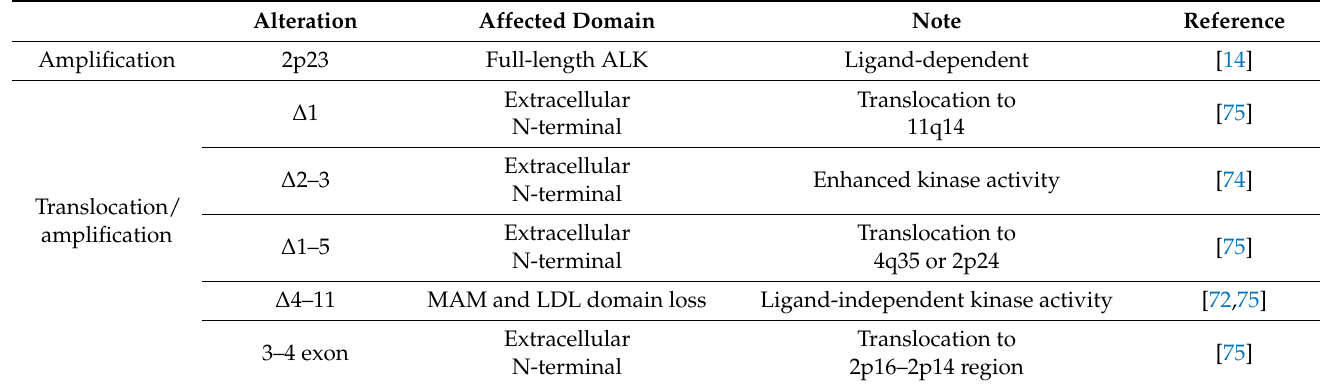
Table 1. ALK alterations described in